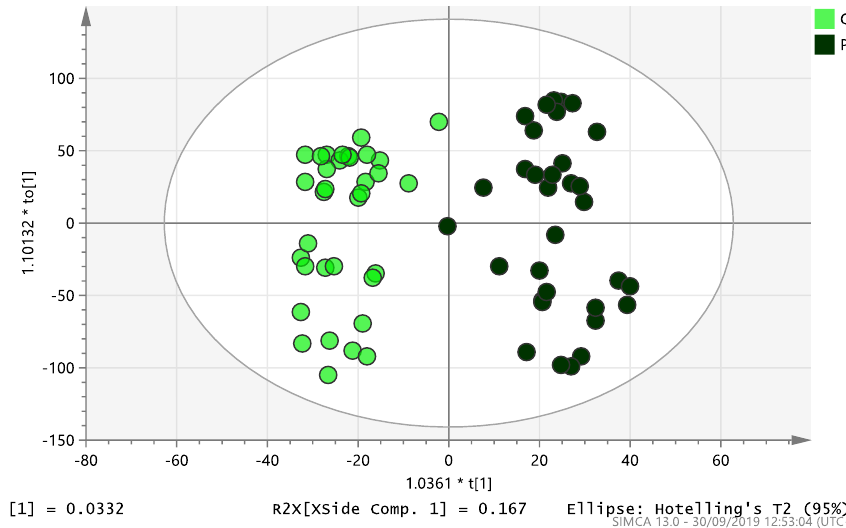
Figure 5. Multivariate analysis based on all detected ions from endometrial tissue. samples: OPLS-DA score plot of control (C, n = 34) and PCOS (P, n = 34). R2X(cum) = 0.228 and Q2(cum) = 0.433.